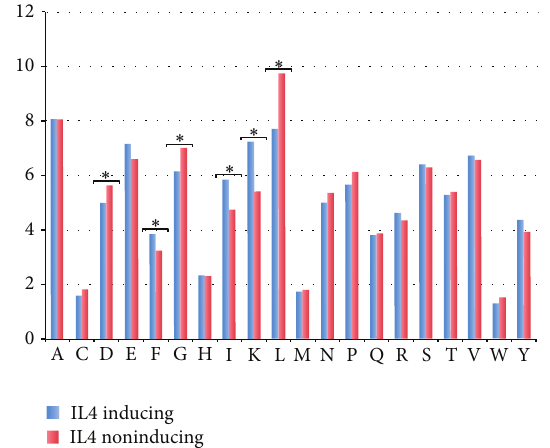
Figure 2: Bar plot representing the average percentage composition of residue in IL4 inducing and non-IL4-inducing datasets. ∗ here represents the significantly different residues at 𝑃 value <